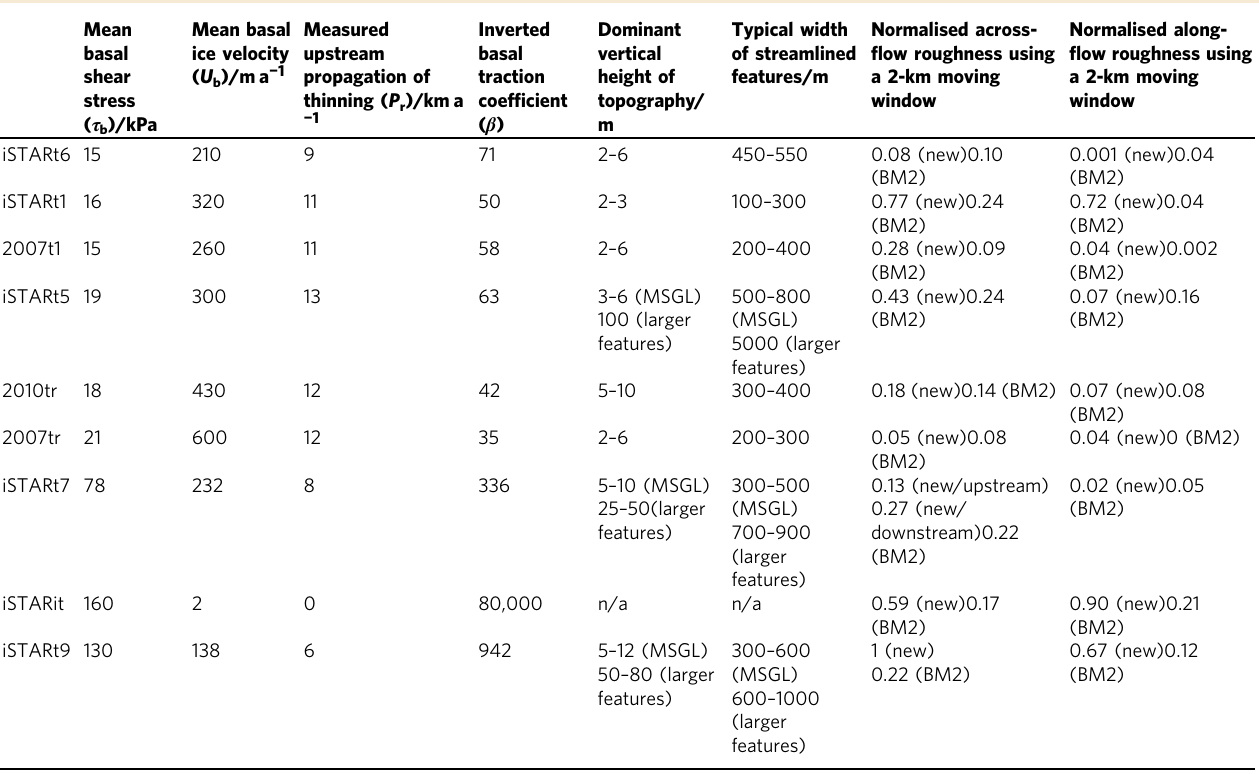
Table 1 Parameters pertaining to ice fl ow and basal topography across each survey patch Mean basal